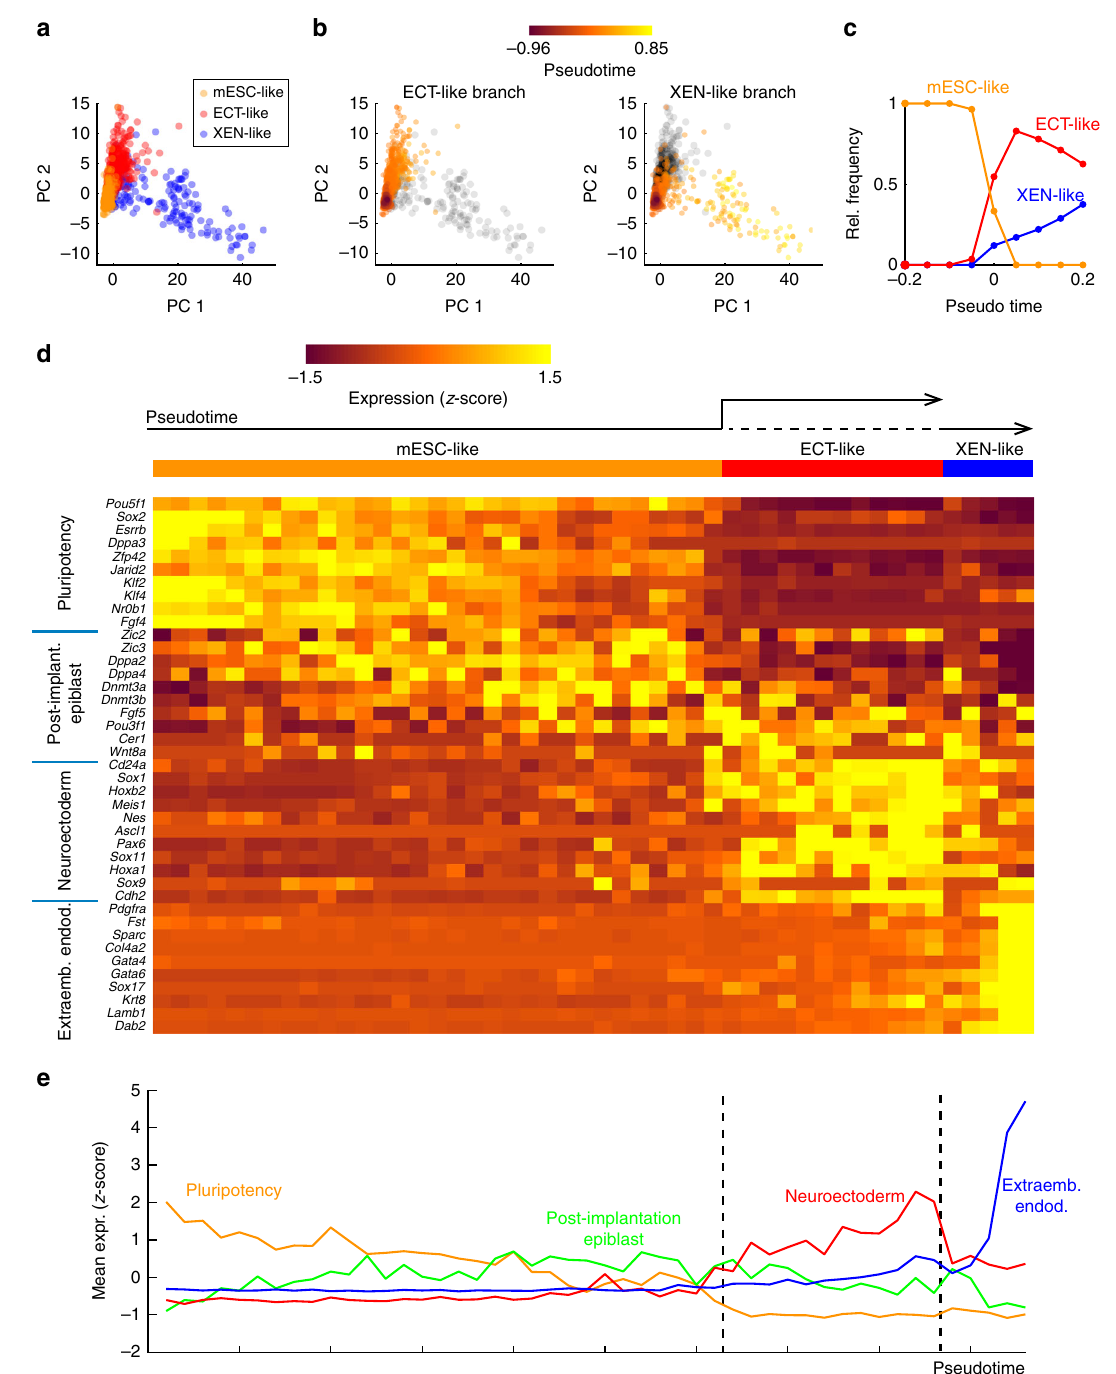
Fig. 3 Pseudo-temporal ordering of SCRB-seq data revealed gene expression dynamics around the exit from pluripotency. a Classi fi cation of all cells measured during the differentiation time course. Cells were classi fi ed according to the correlation of their expression pro fi les with the average expression of mESCs at 0 h or ectoderm- or XEN-like cells at 96 h. Cells were placed in the space of the fi rst two principal components (PC1 and PC2). b Pseudo-time of cells in the ectoderm-like branch (mESC-like cells and ectoderm-like cells, left) or the XEN-like branch (mESC-like cells and XEN-like cells, right). Pseudo-time τ , which is indicated by color, is de fi ned as τ = R pluri − 0.5*(R ect + R xen ) where R pluri , R ect and R xen are the Pearson correlations of an individual expression pro fi le with the average expression of mESCs, ectoderm-like cells at 96 h and XEN-like cells at 96 h, respectively. c Relative frequencies of the three classes of cells with respect to pseudo-time. d Expression of a panel of marker genes for pluripotency, post-implantation epiblast 70 , neuroectoderm and primitive endoderm with respect to pseudo-time. Cells were ordered by increasing pseudo-time and expression was averaged over 50 consecutive cells. Expression is presented as gene-wise z-score to accentuate temporal differences. e Average expression of the 4 sets of marker genes shown in d : pluripotency factors, post-implantation epiblast markers, neuroectoderm markers and extraembryonic endoderm